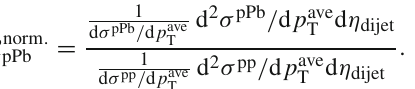
CT14+EPPS16 overshoot, but are still compatible with the data